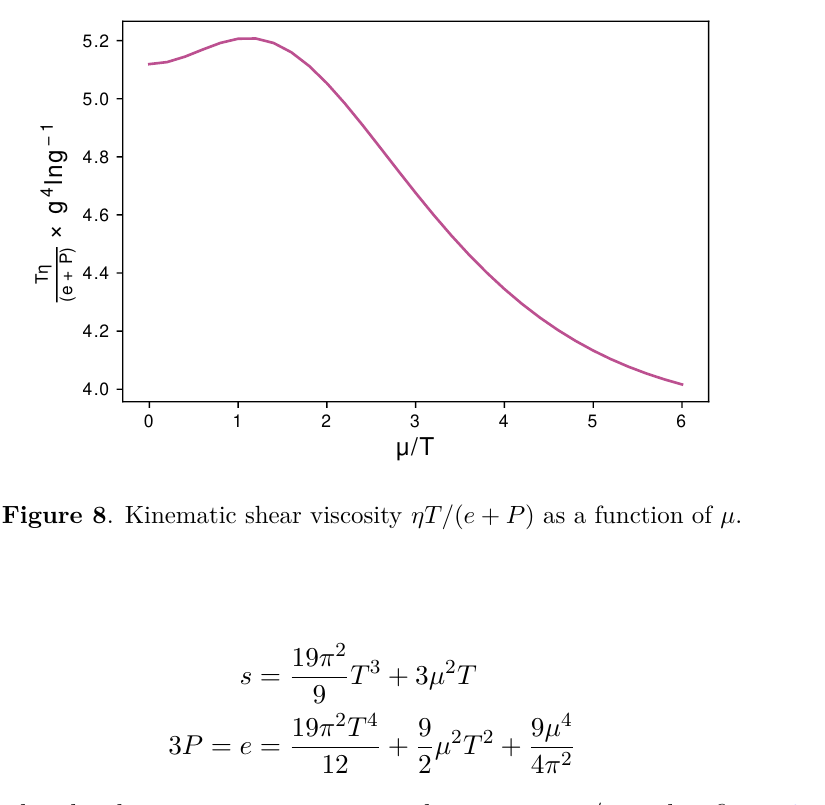
Figure 7 . Shear viscosity divided by the entropy density as a function of µ . The points represent our leading-log calculation. The pink line is a quadratic fit, which gives a fair but imperfect representation of our result.